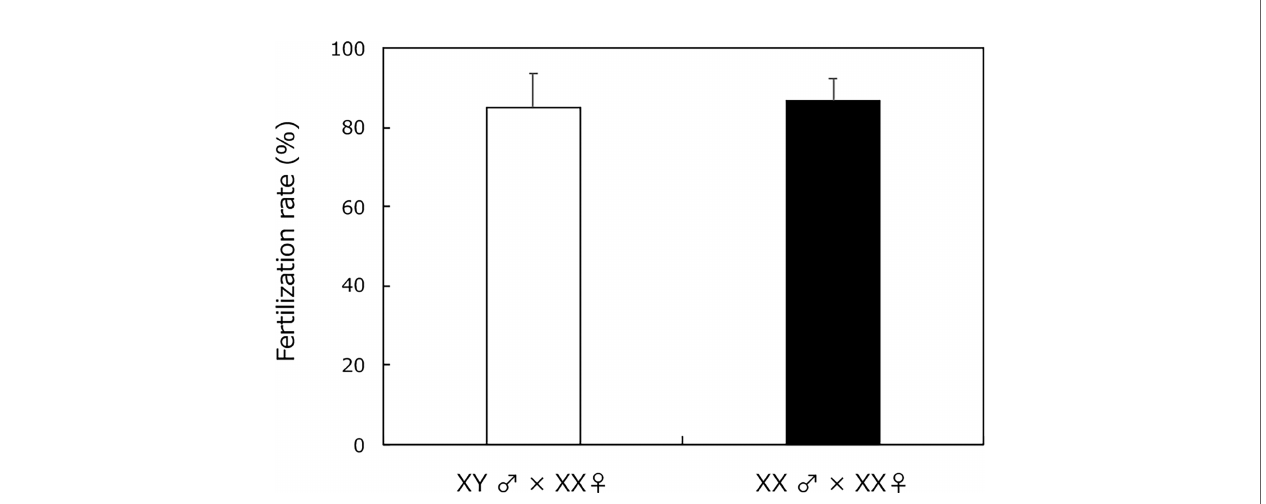
FIGURE 2 | Fertility assessment of adult XY male without H 2 O 2 treatment (white box) and sex-reversal XX male medaka with H 2 O 2 treatment from 0 to 5 dph (black box) using natural mating with fertile partners (XX female medaka). Vertical bar: mean ± standard error of triplicate